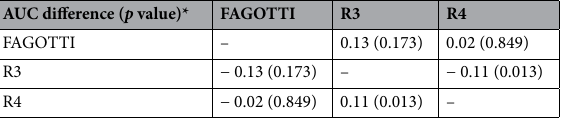
Table 6. Differences in Areas Under ROC Curves. *Reading: row versus column.